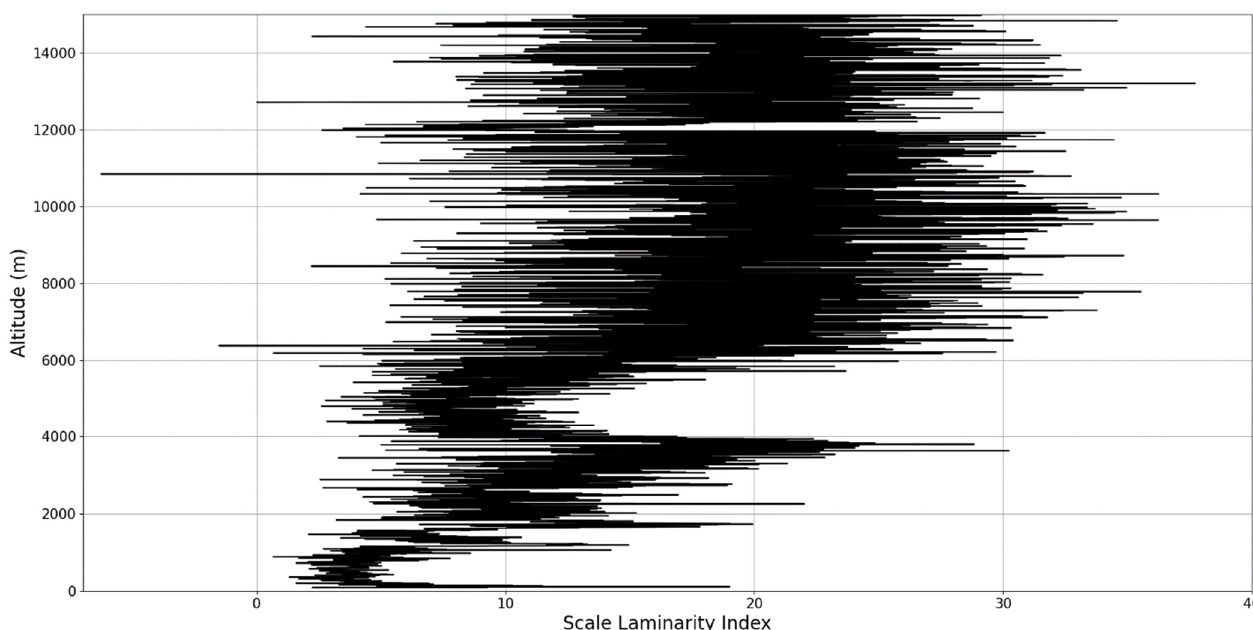
Figure 28. Scale laminarity index profile plot corresponding to point A in the vicinity of the PBLH.